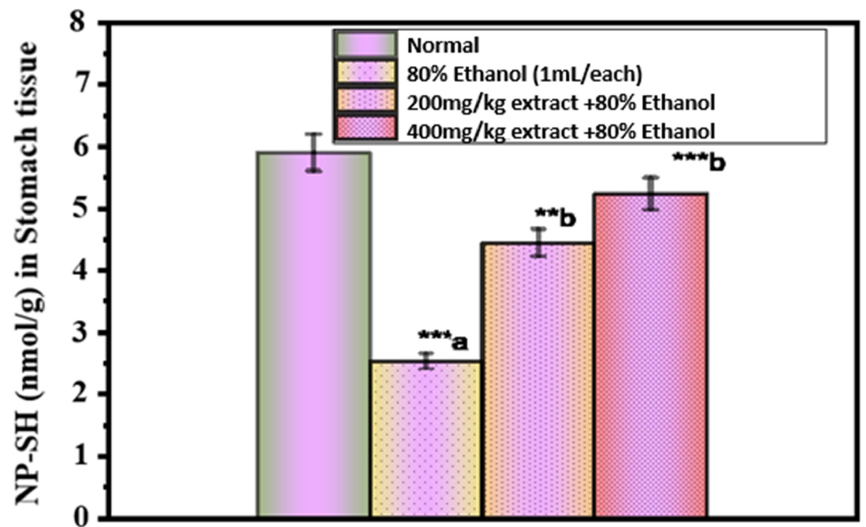
Figure 3. Effect of O. forsskalii extracts on the NP-SH concentration in gastric ulcer induced by 80% ethanol. Six rats were used in each group. p values (** p < 0.01, *** p < 0.001). Where, a: 80% ethanol treated group was statistically compared to the normal group; b: O. forsskalii treated groups were compared to the ethanol-treated group.